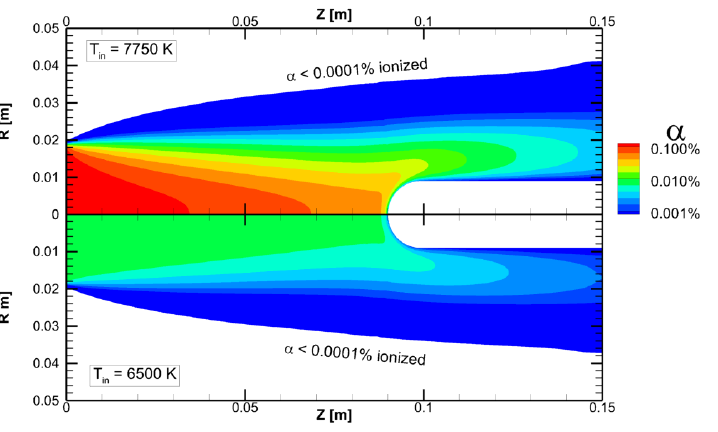
Figure 6. Percent ionization, α = n i / n tot = n e / n tot , for the minimum and maximum inlet tempera- ture cases (1 and 6) simulated.